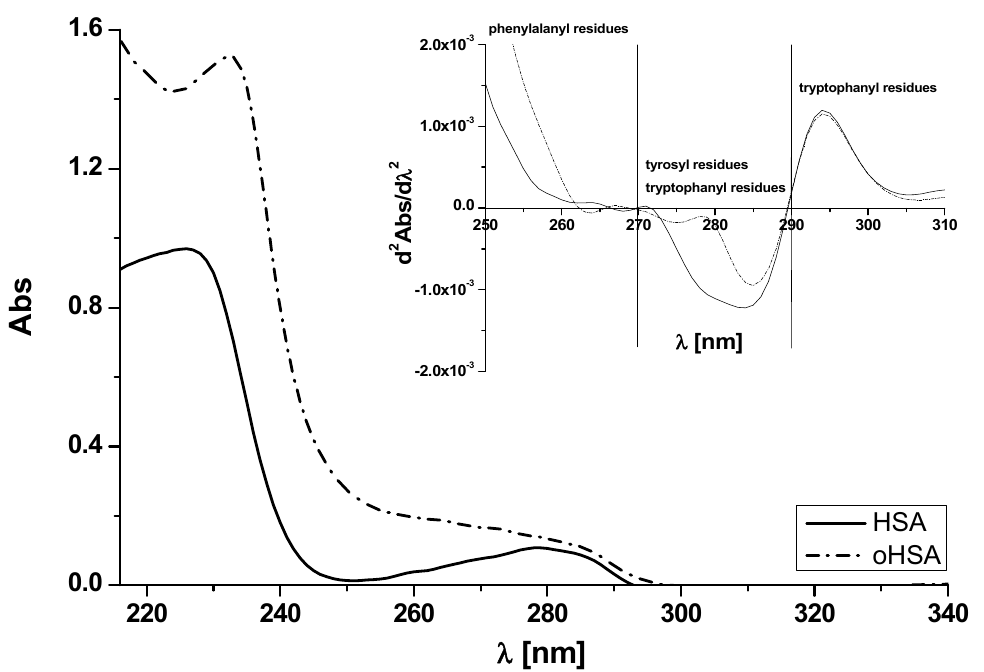
Figure 2. Absorption spectra of unmodified (human serum albumin (HSA)) and oxidized (oxidized human serum albumin (oHSA)) human serum albumin at 5 × 10 − 6 mol · L − 1 concentration. In the insert second derivative of 5 × 10 − 6 mol · L − 1 HSA and oHSA absorption spectrum.